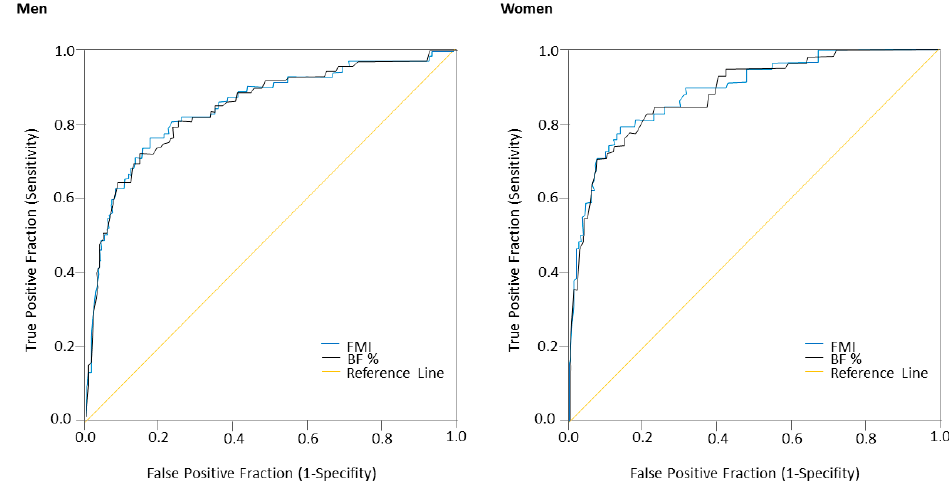
Figure 2. ROC curves for BF% and FMI for prediction of the prevalence of MetS according to IDF criteria in men and